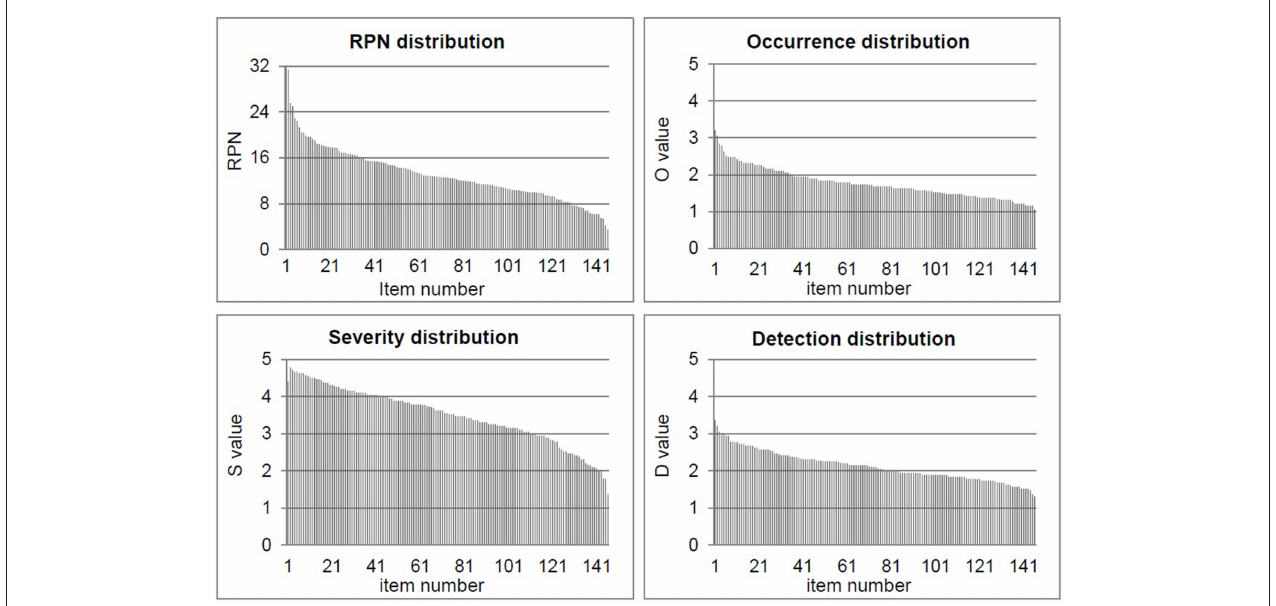
FIGURE 1 | Evaluation of the “occurrence (O),” “severity (S),” “detectability (D),” and “risk priority number (RPN)” for 144 items on a scale from 1 to 10 according to the proposed AAPM TG-100 rating